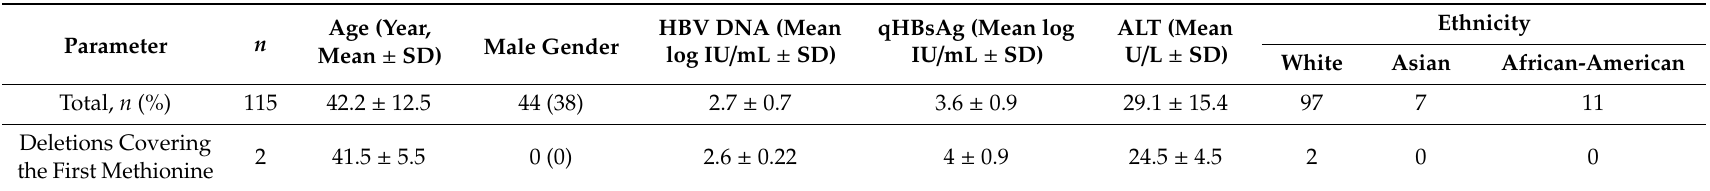
Table 1. Epidemiological, virological and serological characteristics of HBeAg negative patients infected chronically with hepatitis B virus (HBV) Genotype